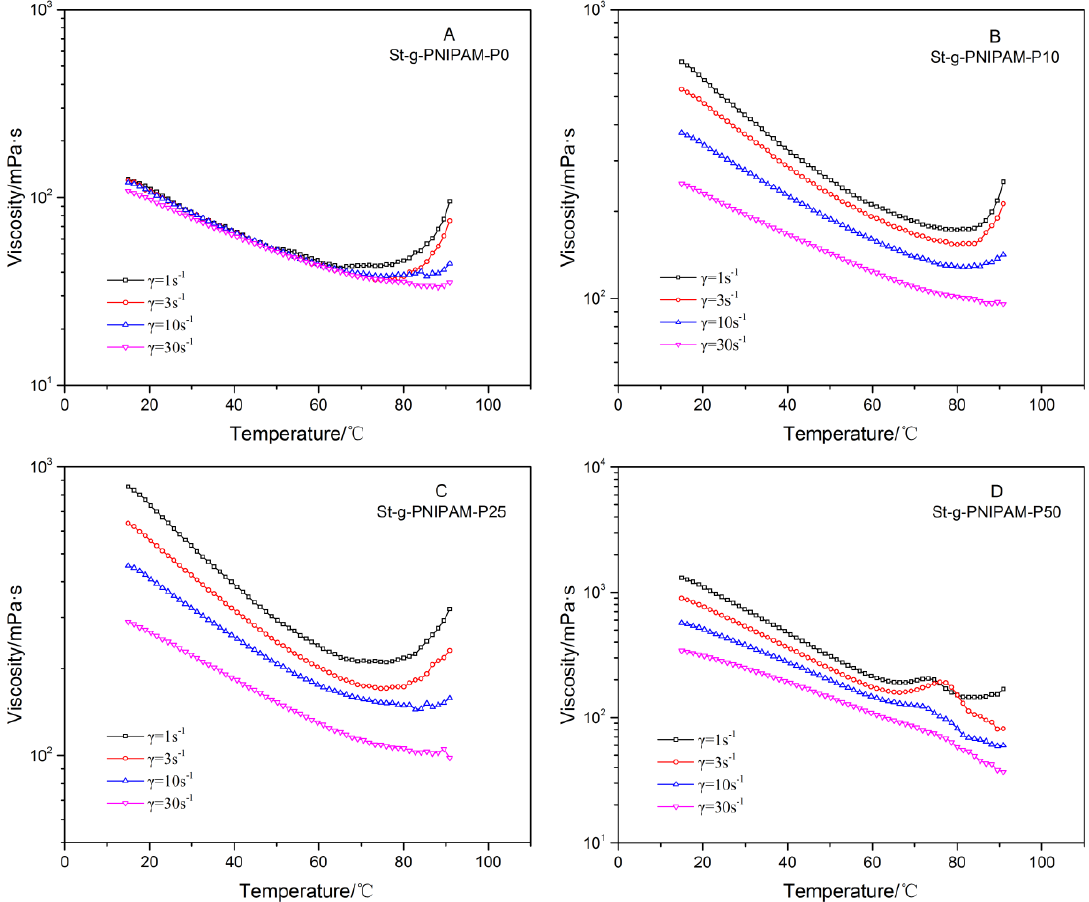
Figure 5. Viscosity versus temperature of ( A ) St-g-PNIPAM-P0; ( B ) St-g-PNIPAM-P10; ( C ) St-g-PNIPAM-P25; and ( D ) St-g-PNIPAM-P50 with 1.2 wt % copolymer